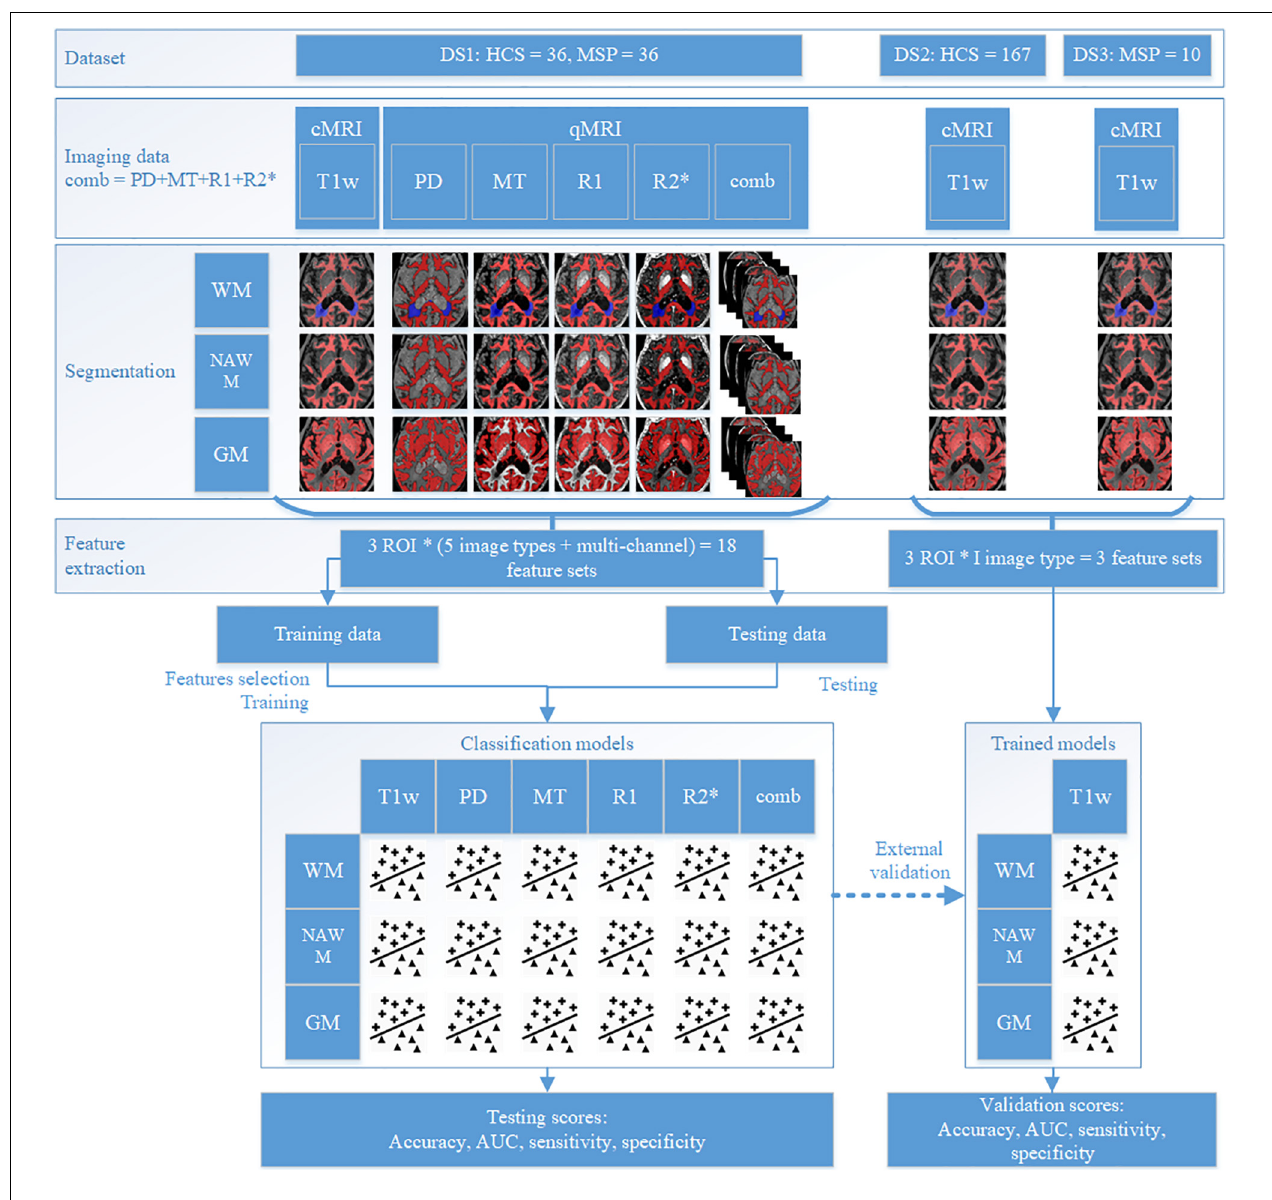
FIGURE 2 | Study design.